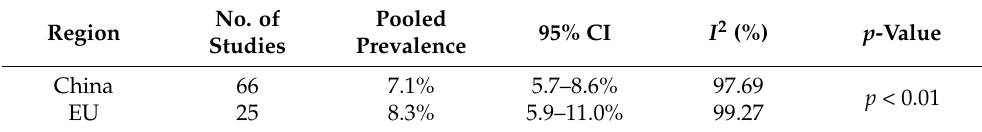
Table 2. Subgroup analysis of the prevalence of L. monocytogenes in different regions. No. of Pooled 95% CI I 2 (%) p -Value Region Studies Prevalence China 66 7.1%